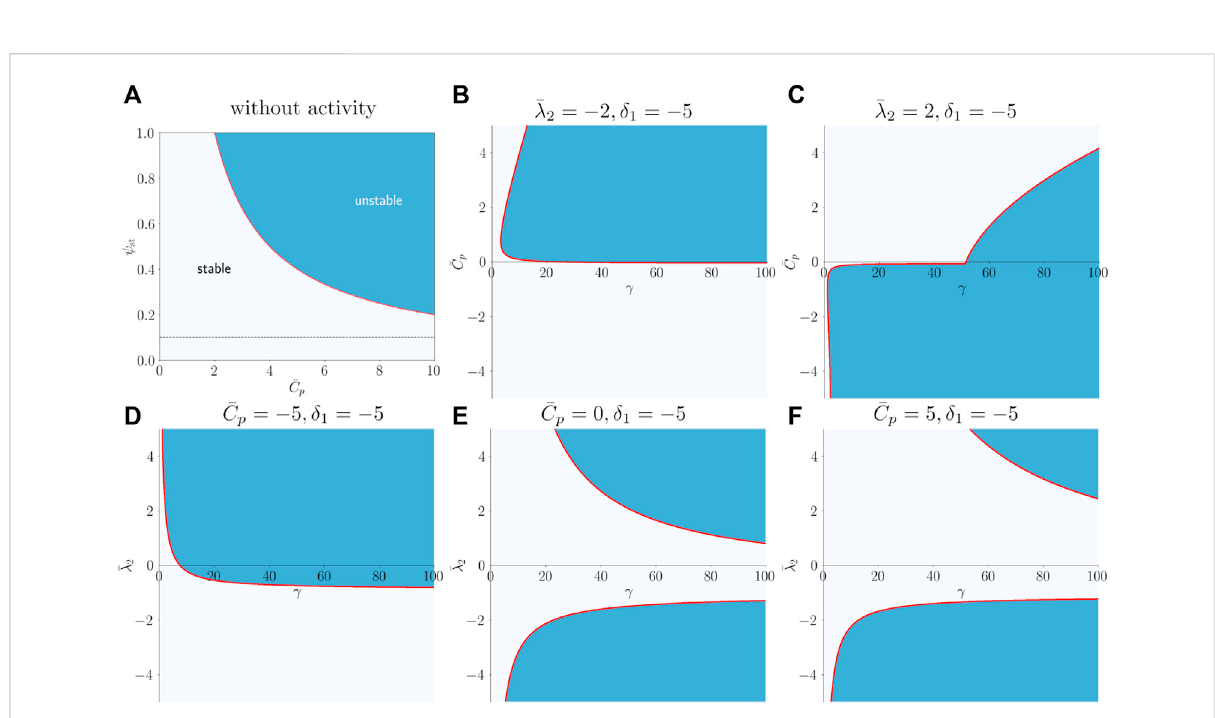
(cid:1) λ – γ plane of stability phase 2 (cid:1) C p while the δ 1 is fi xed. The stability